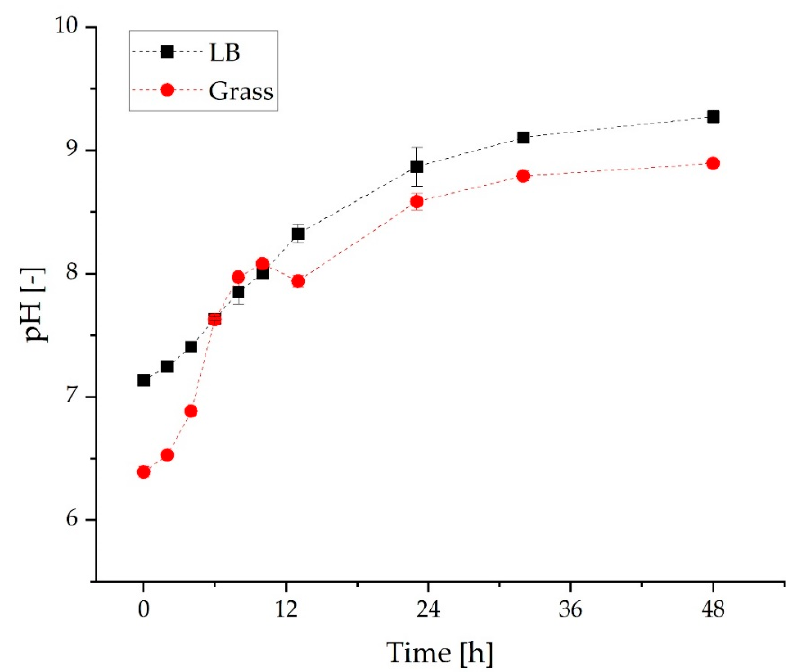
Figure 4. The course of pH of C. necator pKR-hum cultivation in LB medium and grass medium ( n = 3, dashed line serves as a guide to the eye ).